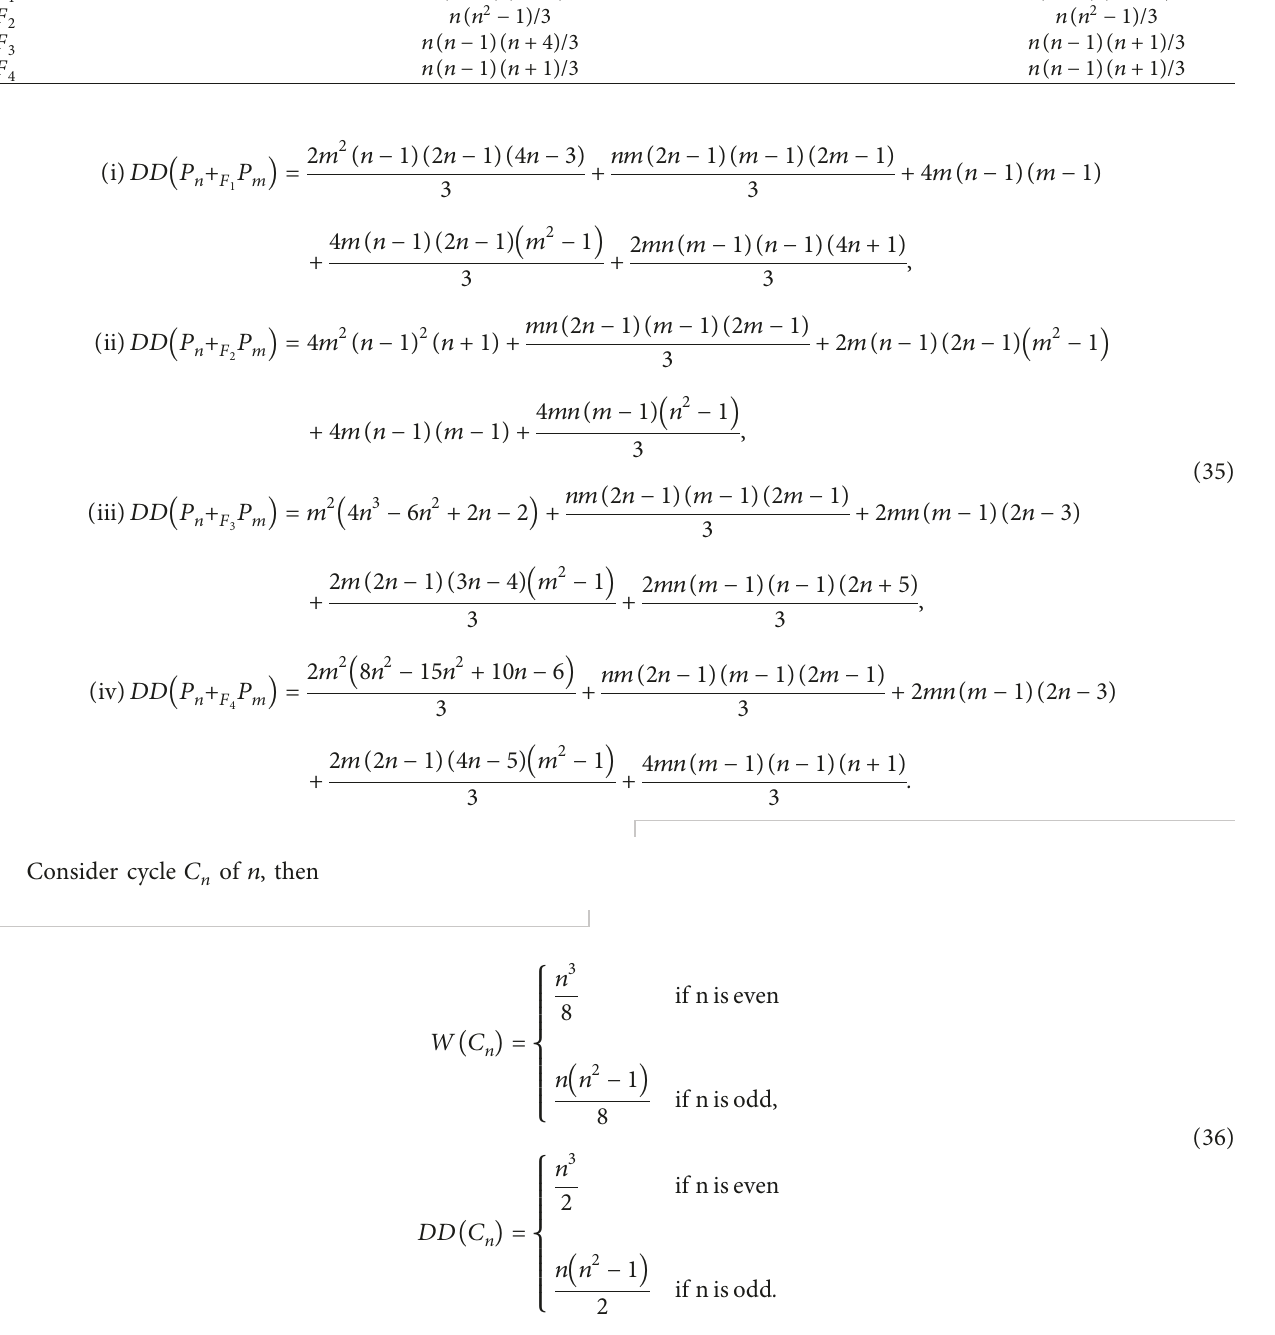
Table 2: Some particular distance sums of F